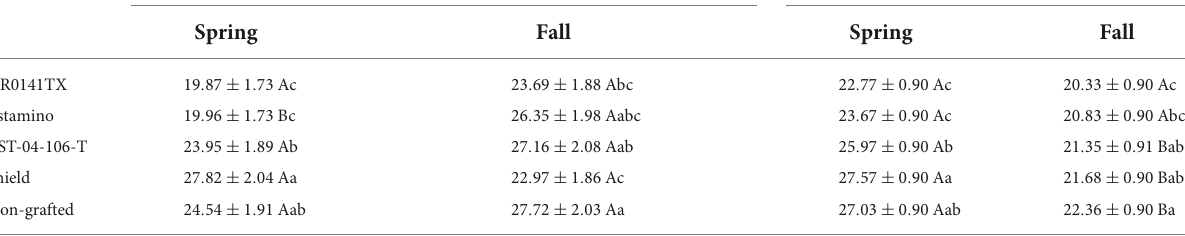
TABLE 10 Total antioxidant capacity and ascorbic acid content of fruit from grafted beefsteak tomato ‘Skyway’ and grape tomato ’BHN 1022’ in Spring and Fall plantings. Rootstock Spring Fall Spring